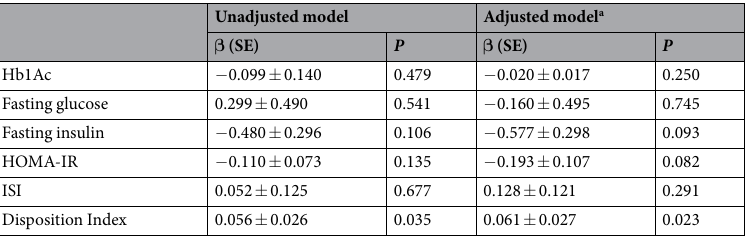
Table 4. Linear regression analysis of cholesterol efflux/apoA-I ratio with glucose metabolism parameters. Data are presented as β ± SE: Unstandardised coefficients ± Standard Error. a Adjusted by age, sex, BMI, smoking status, alcohol drinking, lipid-lowering treatment, and batch